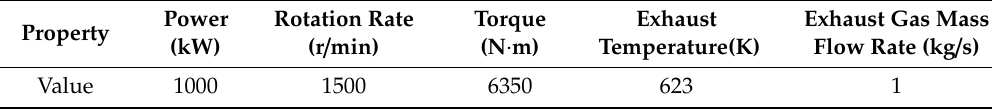
Table 2. The main properties of